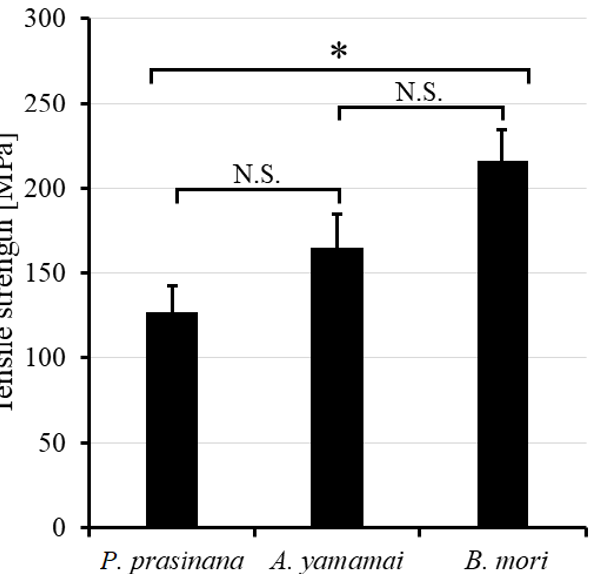
Figure 4. Tensile properties of P . prasinana , B . mori and A . yamamai silk fibers tested after degumming and drying for 2 h. At least four tests were carried out for each fiber type. Error bars indicate standard error of the mean. Asterisk indicates a statistically significant difference ( p < 0.05), N.S. indicates not significant ( p > 0.05).